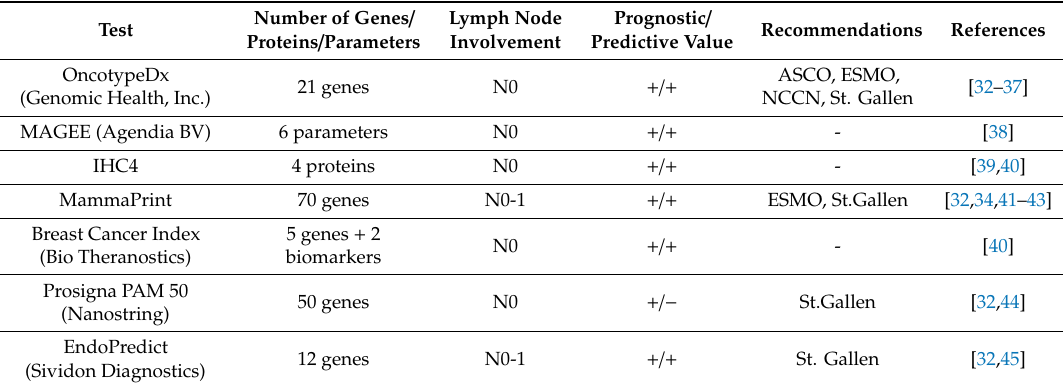
Table 1. Genomic test designed to assess the risk of recurrence in